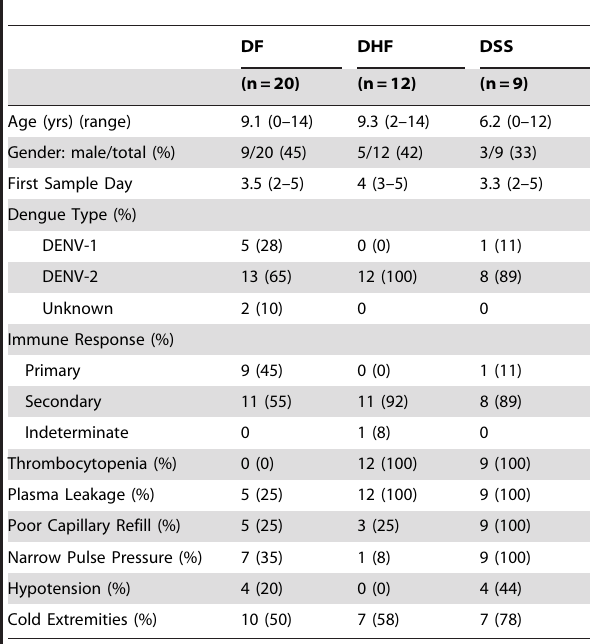
Table 1. Characteristics of study participants with